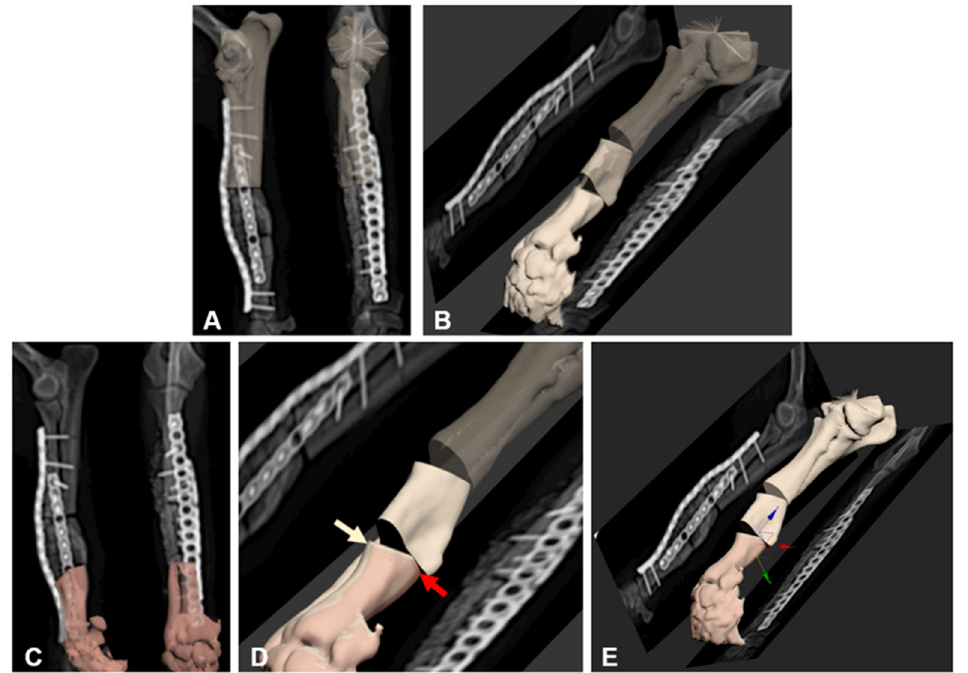
Figure 2. The method for measuring errors between preoperative plan and surgical outcome in computer-aided design (CAD). The proximal segment of the synthetic projection view of preoperative 3D bone images is overlaid with the same part of the postoperative radiograph of the bone in the same plane ( A ). Based on the relative positions in CAD, other bone segments were placed ( B ). In the same manner as in ( A ), one of the other bone segments was overlaid with the same part of the postoperative radiograph on the radiograph plane ( C ). Errors between the preoperative plan (beige arrow) and the surgical outcome (red arrow) were then measured ( D ). The degree of translation/rotation was measured on the x, y, z axes ( E ).